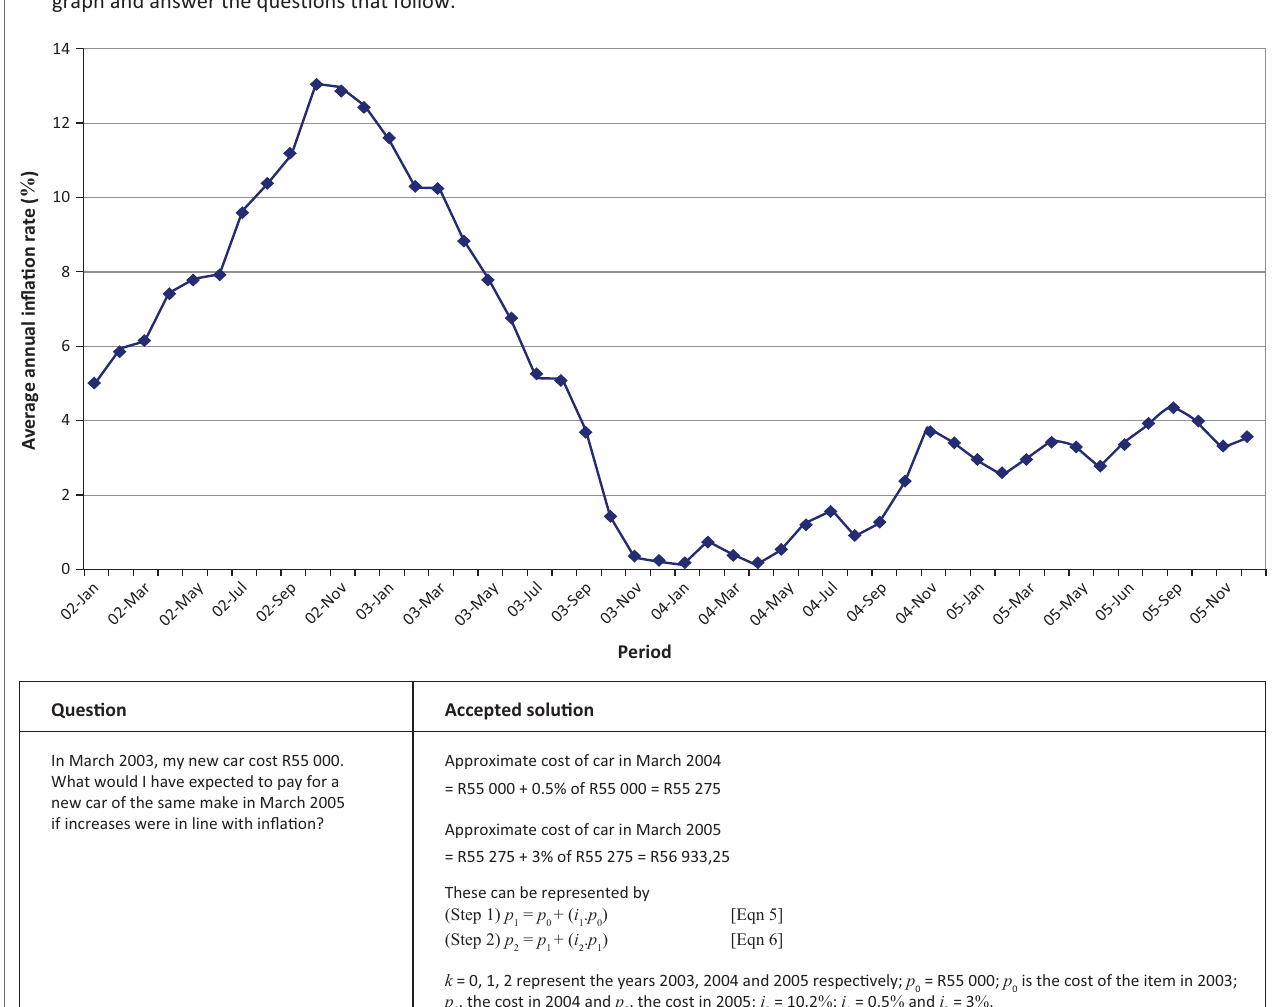
FIGURE 2: Task with suggested